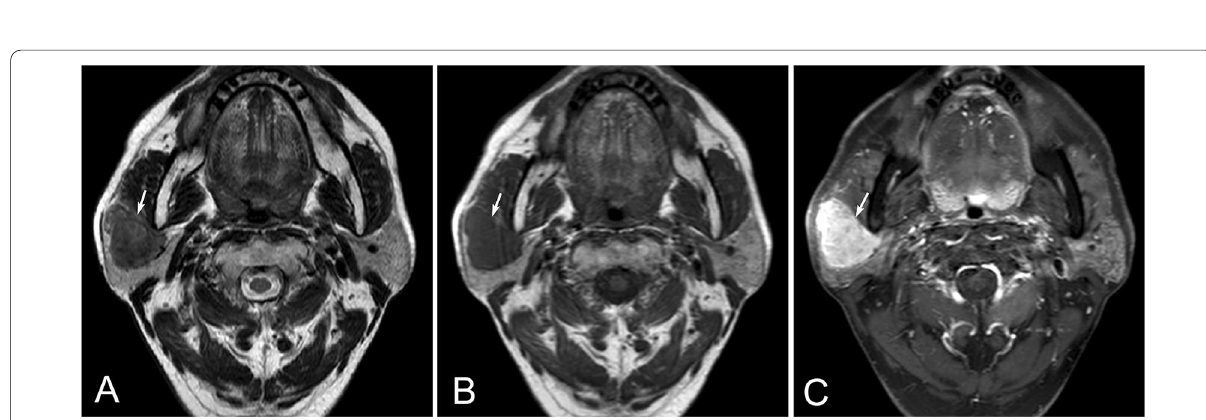
Fig. 4 A 57 years old male with primary parotid MEC in the right parotid gland. Axial T2WI ( A ) and T1WI ( B ) show a well-defined, oval mass in the superficial part of the right parotid gland (arrow). The mass is hypointense on T2WI, and hypointense on T1WI. Contrast-enhanced axial ( C ) T1WI shows the tumor is homogeneous enhancement without necrosis